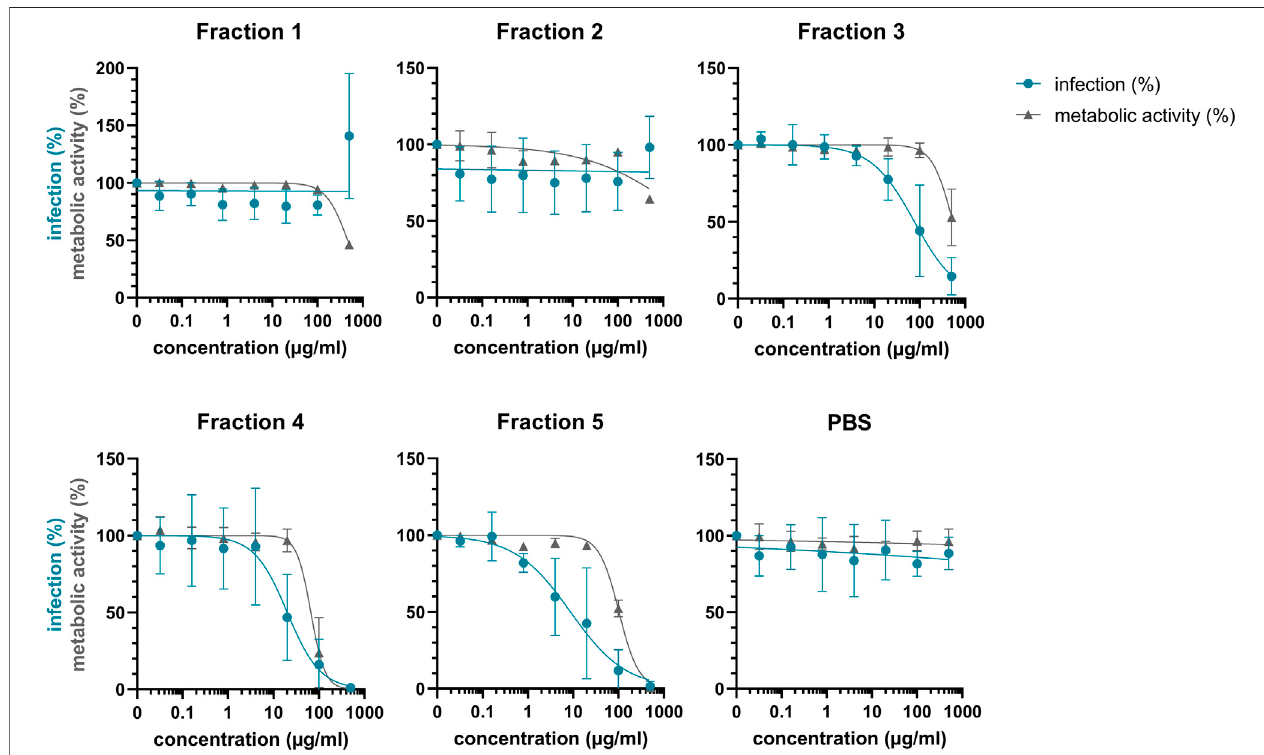
FIGURE3| Anti-HIV-1 activityof Violatricolor peptide-enrichedfractions.Extract#2( V.tricolor )wasfractionatedandfractionsdissolved inPBS.Then,fractions1- 5 and PBS control were titrated and added to TZM-bl cells. Cells were infected with HIV-1 (infection, blue) or medium was added (metabolic activity, grey). 2 days later, infection and metabolic activity was quanti fi ed via β -galactosidase or MTT-based assay, respectively. Data are normalized to untreated controls and represented as means ± SD of three independent experiments in